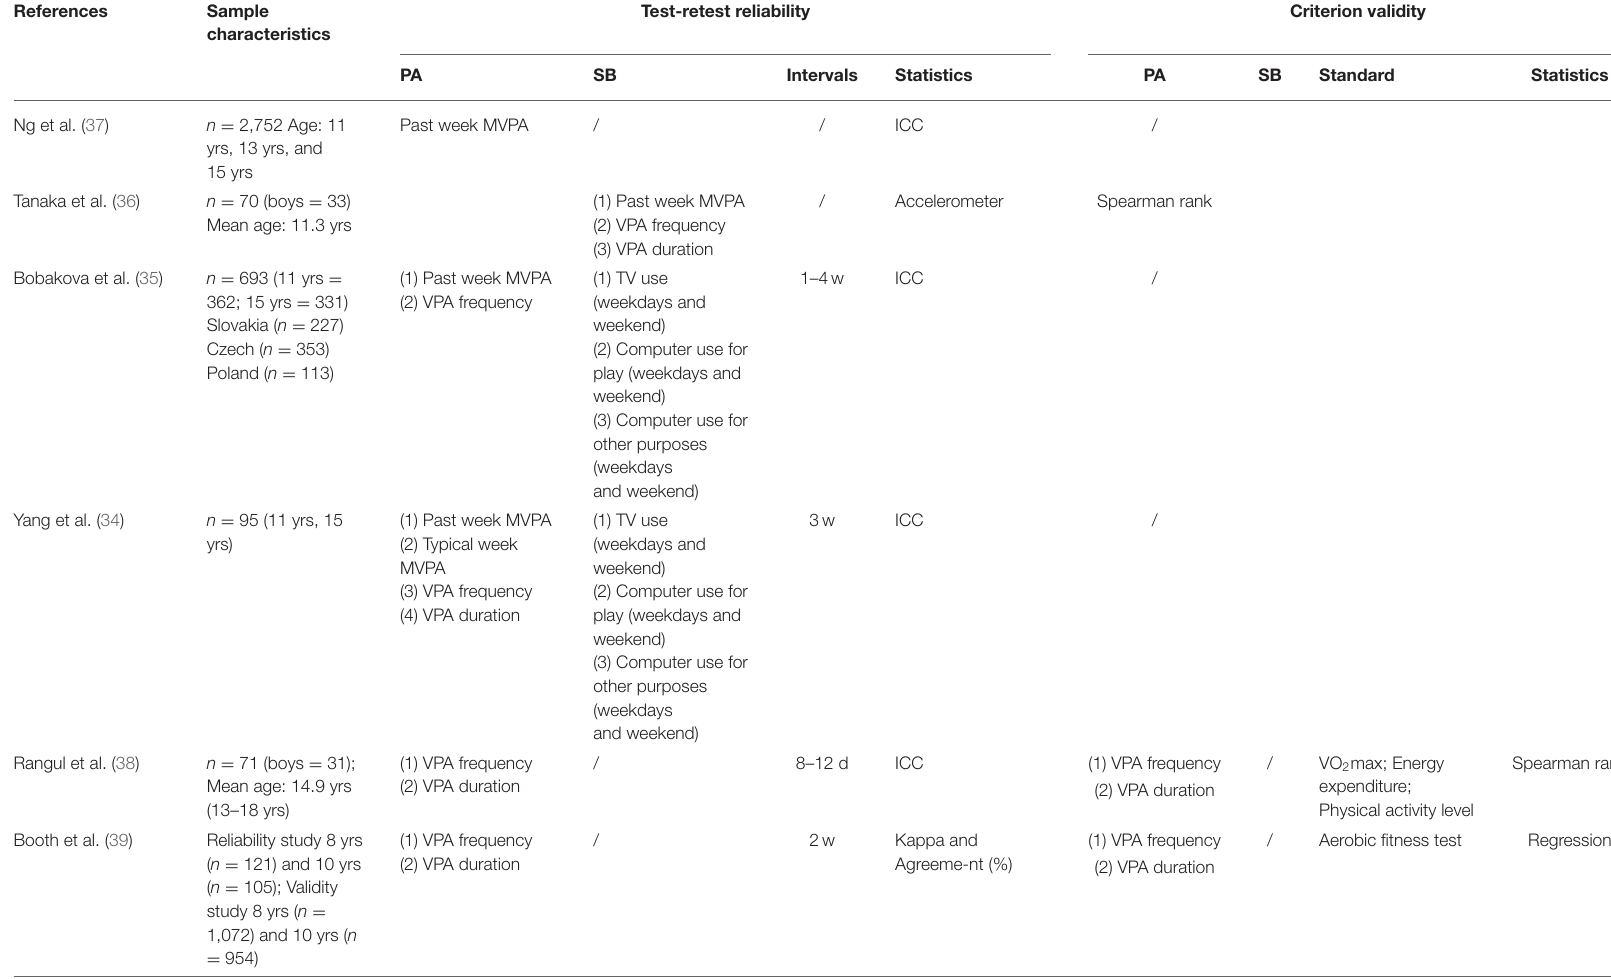
TABLE 2 | Basic information of the included